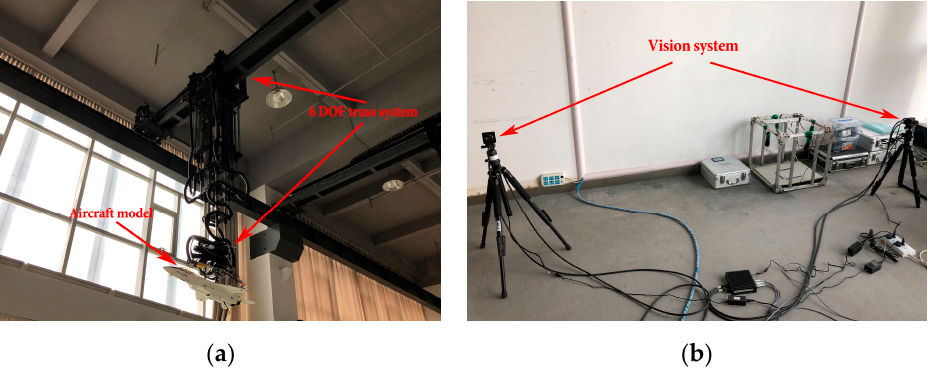
Figure 16. The set-up for our ground laboratory experiment: ( a ) the aircraft model and six degree of freedom (DOF) truss system; ( b ) the vision system consisting of two calibrated and synchronized monocular cameras.